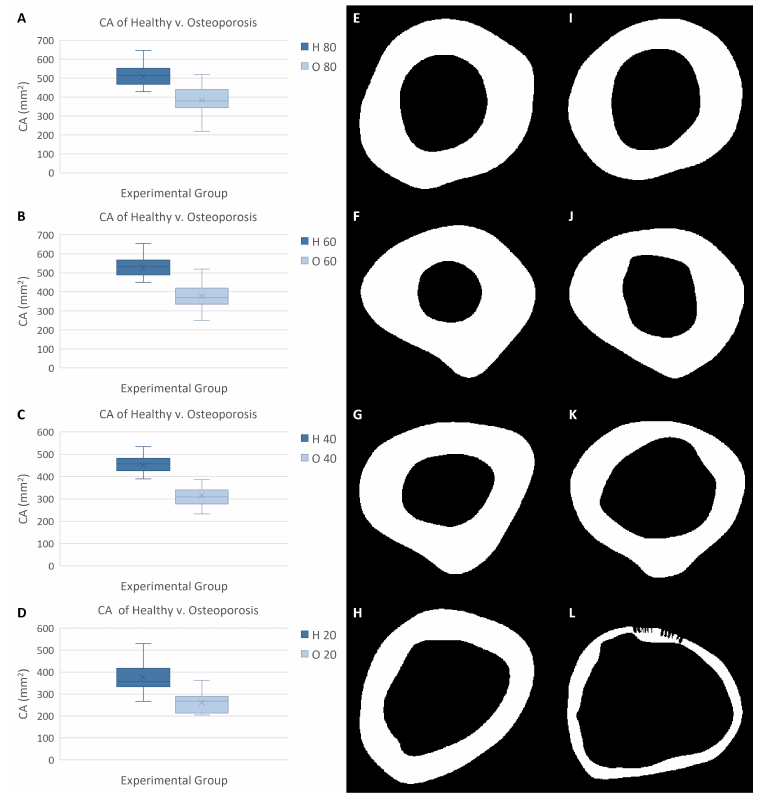
Figure 6. Cortical area (CA) data of healthy and osteoporosis experimental groups. ( A ) CA data from 80% biomechanical length (BL). ( B ) CA from 60% BL. ( C ) CA from 40% BL. ( D ) CA from 20% BL. ( E ) Healthy femur CA (shown in white) at 80% BL. ( F ) Healthy femur CA at 60% BL. ( G ) Healthy femur CA at 40% BL. ( H ) Healthy femur CA at 20% BL. ( I ) Osteoporotic femur CA at 80% BL. ( J ) Osteoporotic femur CA at 60% BL. ( K ) Osteoporotic femur CA at 40% BL. ( L ) Osteoporotic femur CA at 20%